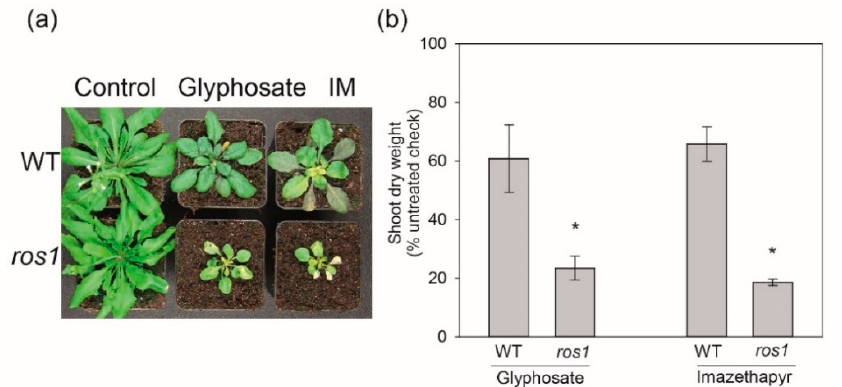
Figure 3. ( a ) Visual effect ( b ) shoot dry weight of A. thaliana Col-0 wild type (WT) and ros1 mutant corresponding to study 3, 10 days after treatment (DAT) of glyphosate and imazethapyr (IM). Error bars indicate the standard deviation of four biological replicates, statistically significant differences relative to WT is indicated by asterisk ( t -test, p ≤ 0.05); * compared to WT.